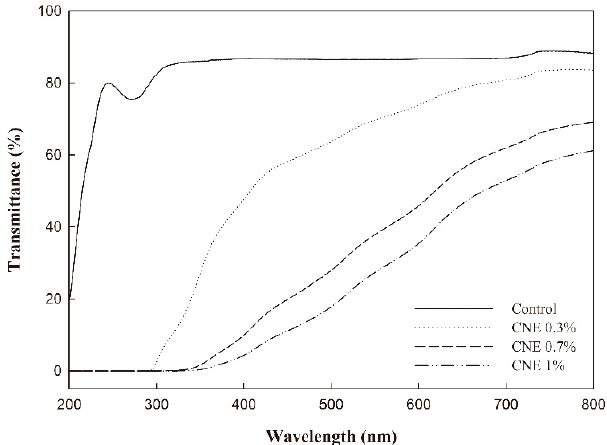
Figure 2. UV-visible light transmittance of adzuki bean starch films.